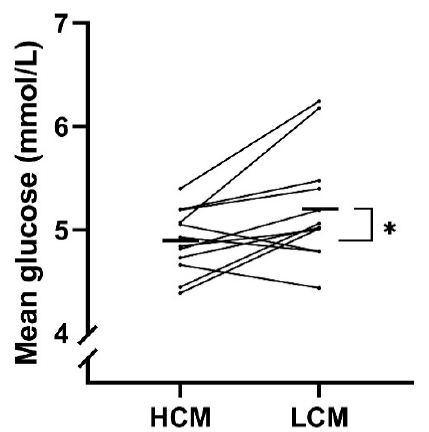
Figure 3. Treatment e ff ect on mean glucose (MG) for each participant following a diet with high carbohydrate load (HCM) and a diet with low carbohydrate load (LCM) in the morning. Mean values of the treatment e ff ect of each period are marked with black lines. HCM, high carbohydrate and energy content in the morning; LCM, low carbohydrate and energy content in the morning; MG, mean